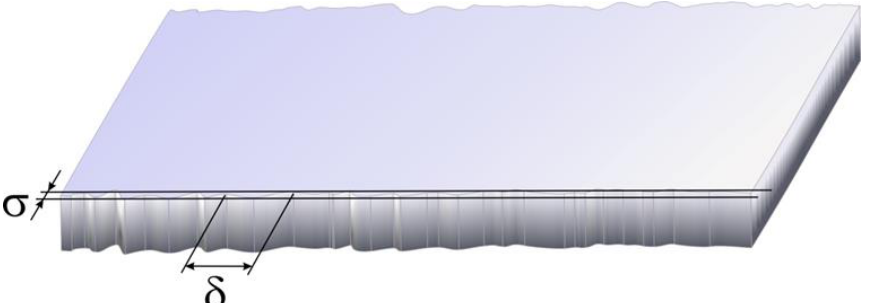
Figure 5. Schematic of the waveguide with “rough”side wall.